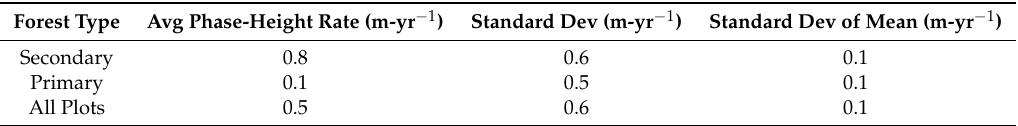
Table 1. Average, standard deviation, and standard deviation of the mean of phase-height rate for secondary forests, primary forests, and all